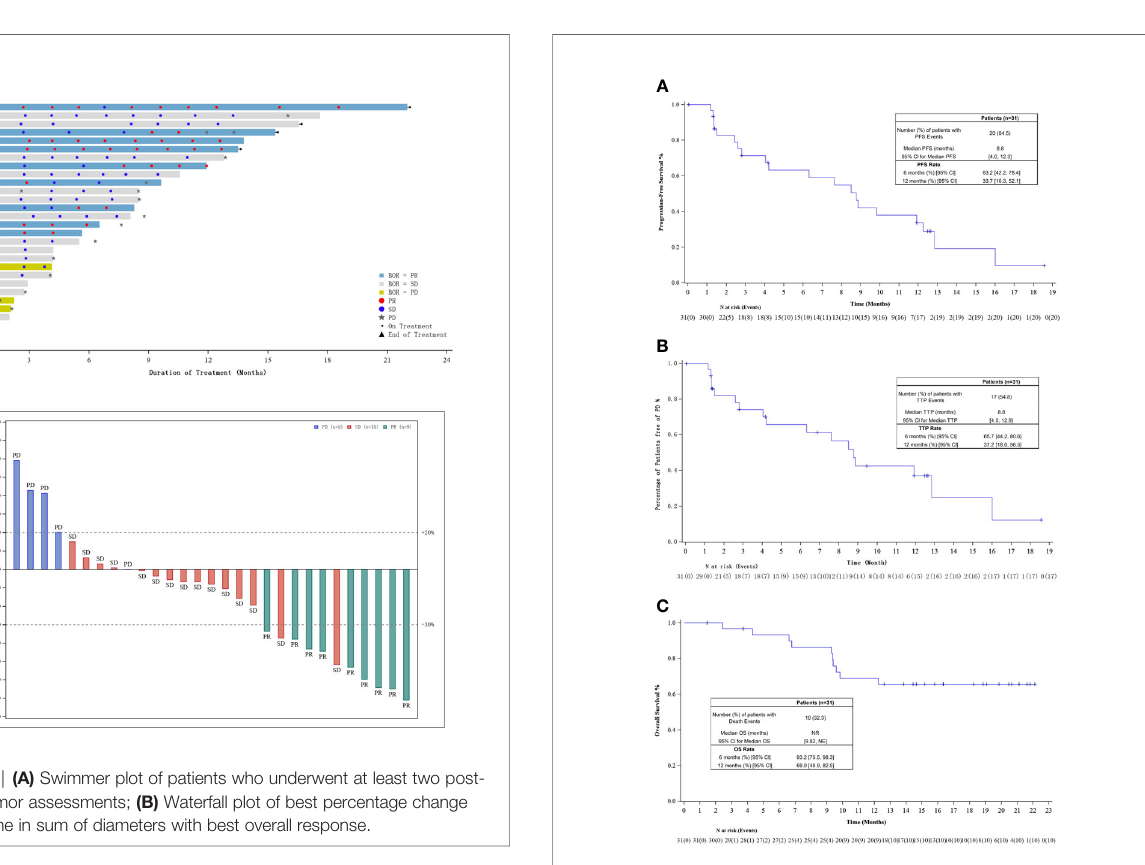
FIGURE 3 | (A) Kaplan – Meier plot of progression-free survival (PFS); (B) Kaplan – Meier plot of time to progression (TTP); (C) Kaplan – Meier plot of overall survival (OS).